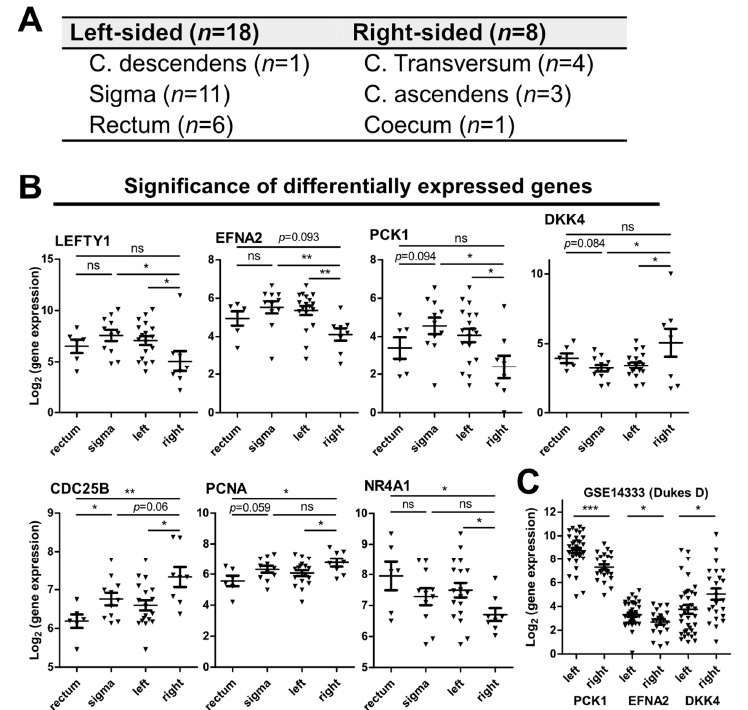
Figure 5. The post-therapeutic signature genes classifies primary tumor and liver metastasis. Com- parison of P and M tumor tissue using DEG signature A (unmatched/all samples; ( A , C )) and B (paired samples; ( B , D )). ( A , B ) unsupervised heatmaps. Clustering of P and M samples is indicated. ( C – F ) Principal component analyses (PCA) utilizing genes included in DEG signature A ( C , E ) and B ( D , F ). ( C , D ) REVEAL data set. ( E , F ) GSE131418 data set. Patients with CRCs originating on the right side of the colon have a worse prognosis than patients with left-sided CRCs [38,39]. To find sidedness markers in the REVEAL co- hort the expression pattern in left-sided primary tumors (L, n = 18) was compared with right-sided cancers (R, n = 8) (Figure 6). Seven genes displayed a significantly differential expression including the left–right asymmetry determination marker LEFTY1 [40]. The expression pattern of three additional genes was confirmed in an independent dataset GSE14333 (Dukes’ D; L, n = 36; R, n = 23) (Figure 6C). Namely, expression of EFNA2 ( p = 0.0039) and, interestingly, of one of our signature genes PCK1 ( p = 0.0117) were associated with left whereas DKK4 ( p = 0.0235) with right-sidedness. This association was also ob- served in only sigmoid colon-derived cancers ( n = 11) but not in cancers of rectal origin ( n = 6) in the REVEAL cohort, supporting distinct molecular characteristics of sigmoid colon and rectal cancer [41].